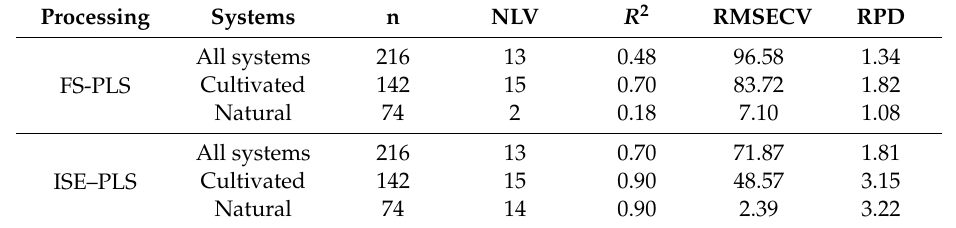
Table 5. Comparison of di ff erent soil oxalate-extractable P prediction models for all land-use systems. Processing Systems n NLV R 2 RMSECV RPD All systems 216 FS-PLS